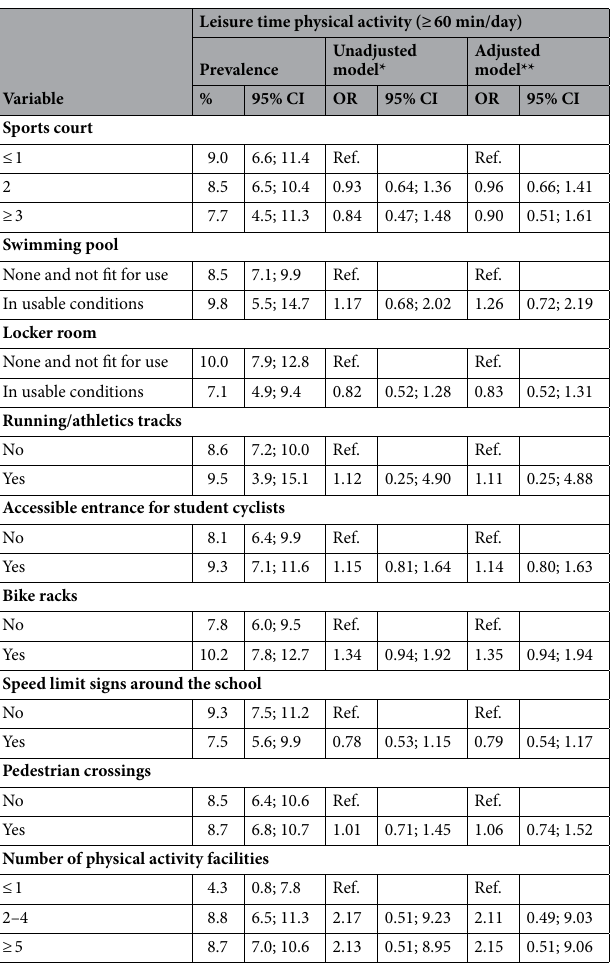
Table 5. Association between school characteristics and leisure time physical activity in adolescents. 95% CI 95% confidence intervals, OR odds ratio. *Number of adolescents enrolled in the school as first level and type of school as second level. **Number of adolescents enrolled in the school as first level, type of school as second level, adjusted by sex, age (years), skin color/ethnicity, and mother’s employment